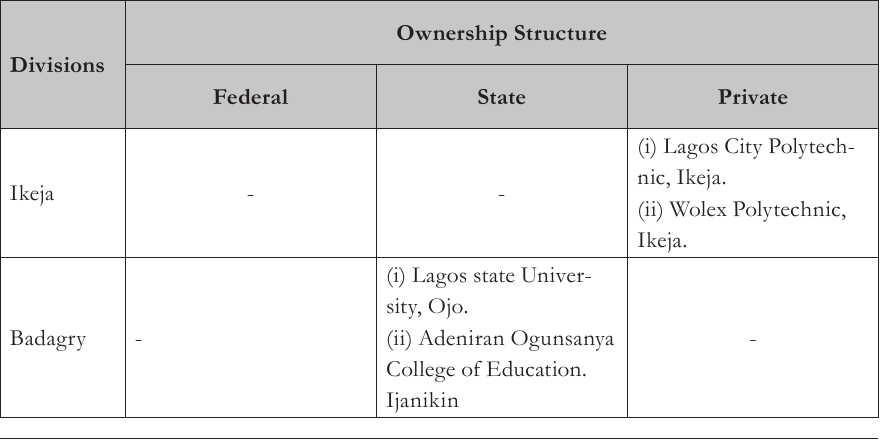
Tab. 1 - Tertiary Institutions in Lagos divisions and their